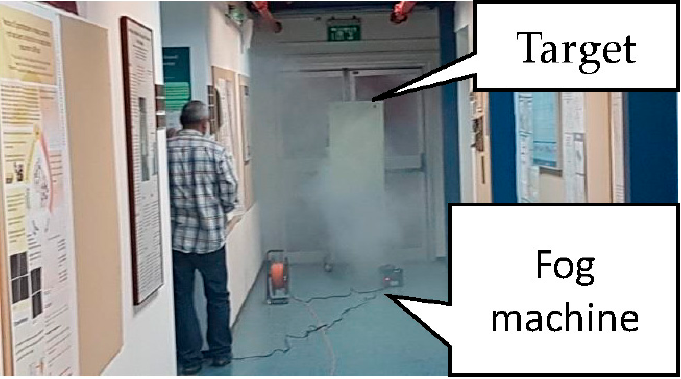
Figure 5. The corridor and the fog streaming start-up.